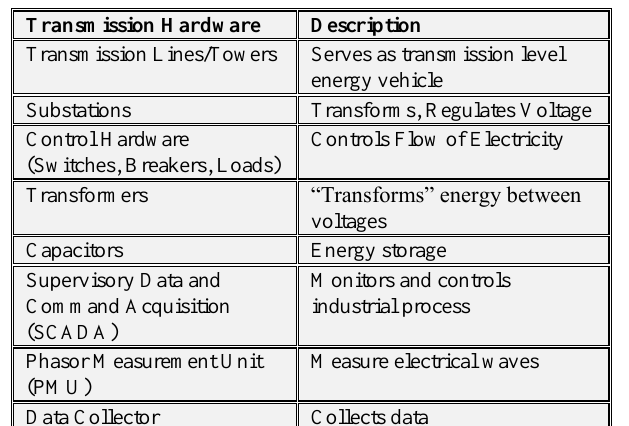
Table 1: Common Grid Hardware [2,12]